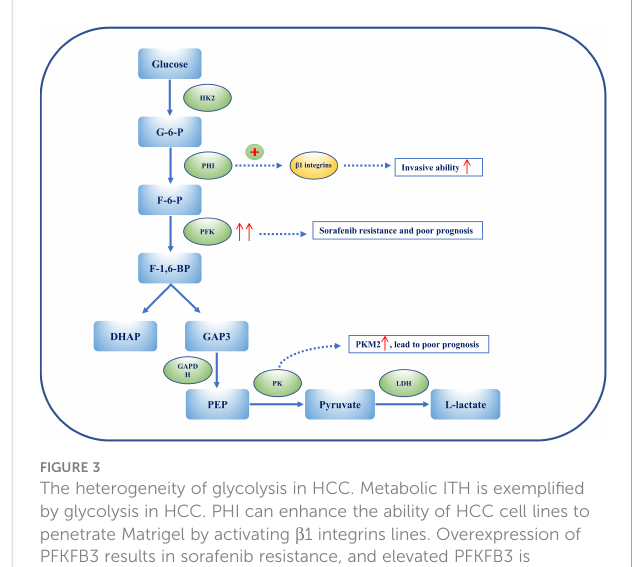
FIGURE 3 The heterogeneity of glycolysis in HCC. Metabolic ITH is exempli fi ed by glycolysis in HCC. PHI can enhance the ability of HCC cell lines to penetrate Matrigel by activating b 1 integrins lines. Overexpression of PFKFB3 results in sorafenib resistance, and elevated PFKFB3 is generally associated with poor outcomes and worse clinical manifestations in HCC. Among PKs, PKM2 is considerably up- regulated in HCC patients, and this is associated with a poor prognosis. Overexpression of PKM2 results in an increase in IFN g - positive CD8+ T cells in the HCC mouse model by activating the immune checkpoint